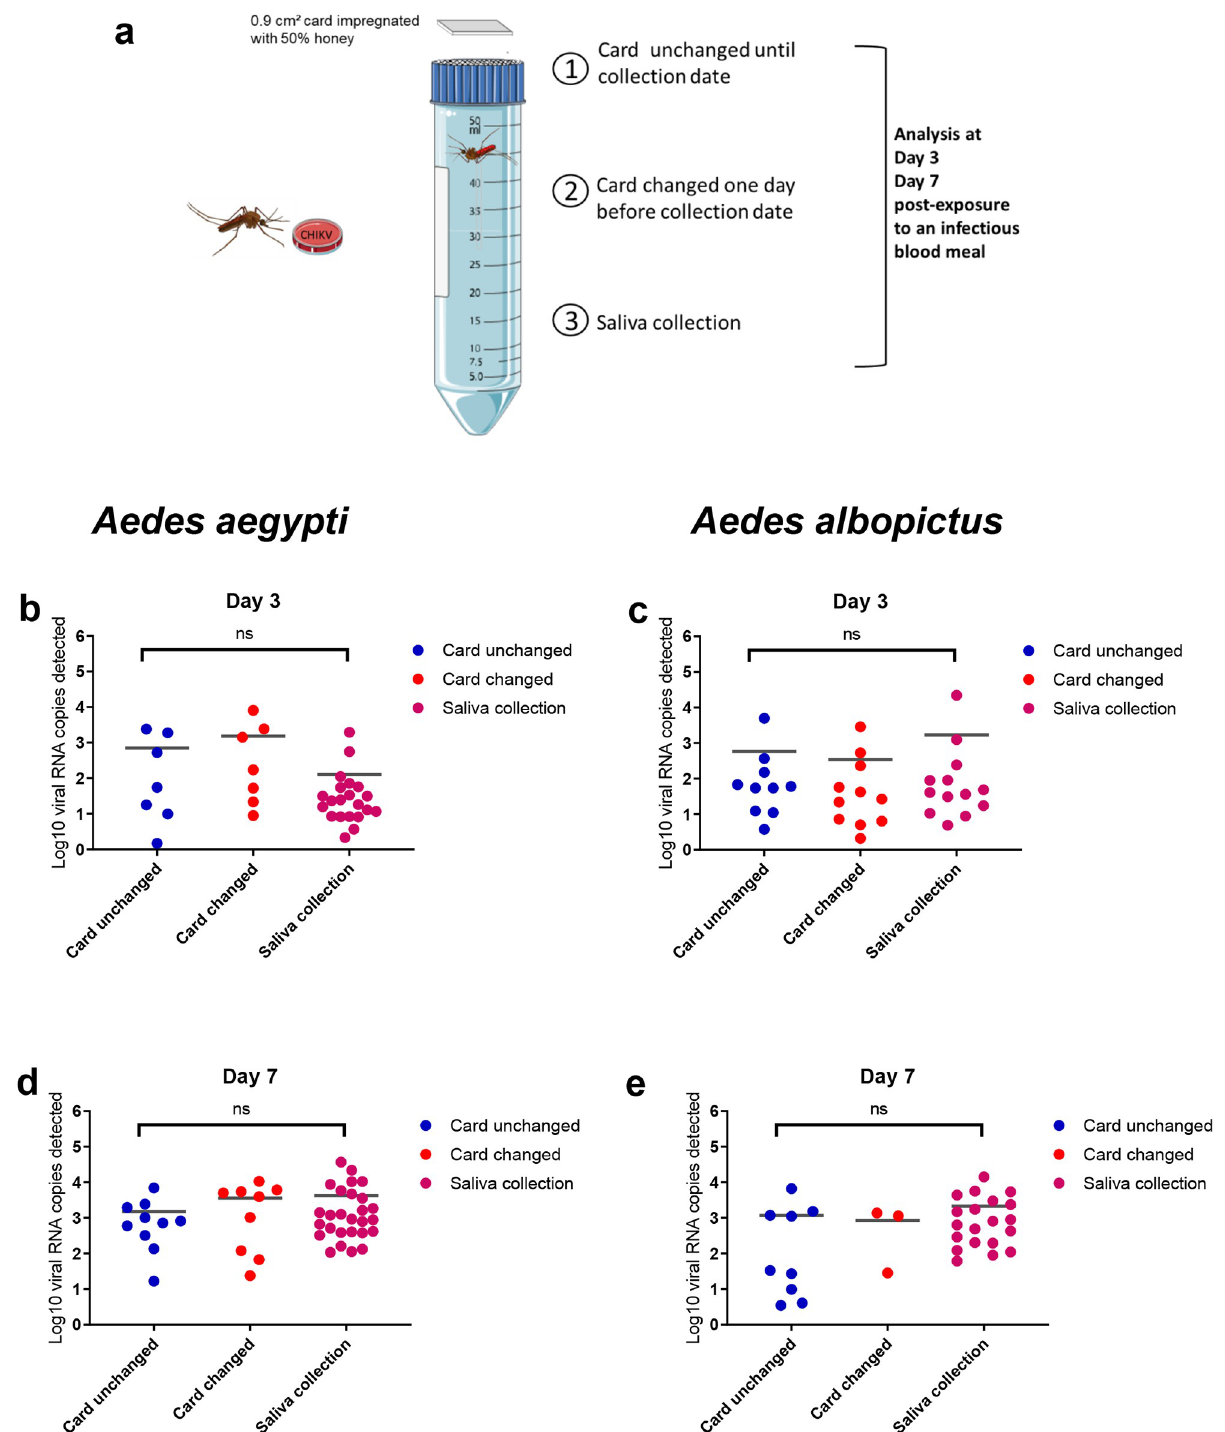
Fig 2. CHIKV-infected saliva detected on cards, 3 and 7 days after exposure of Aedes aegypti (b, d) and Aedes albopictus (c, e) to an infectious blood meal. (a) Mosquitoes were exposed to a CHIKV infectious blood meal at 10 6.5 pfu/mL and maintained in individual tubes at 28˚C. A 0.9 cm 2 of 50% honey impregnated card was deposited on the top of tubes. Filter papers were (1) changed one day before examination or (2) kept unchanged until examination, and compared to the typical (3) saliva collection using the forced salivation technique. The number of viral RNA copies were estimated by qRT-PCR. Each dot represents an individual mosquito. Between 11 to 60 mosquitoes were analyzed for Ae . aegypti and 5 to 46 for Ae . albopictus . Three replicates were performed per condition. Bars indicate the mean. ns (non-significant) indicates the lack of statistical significance (p > 0.05).